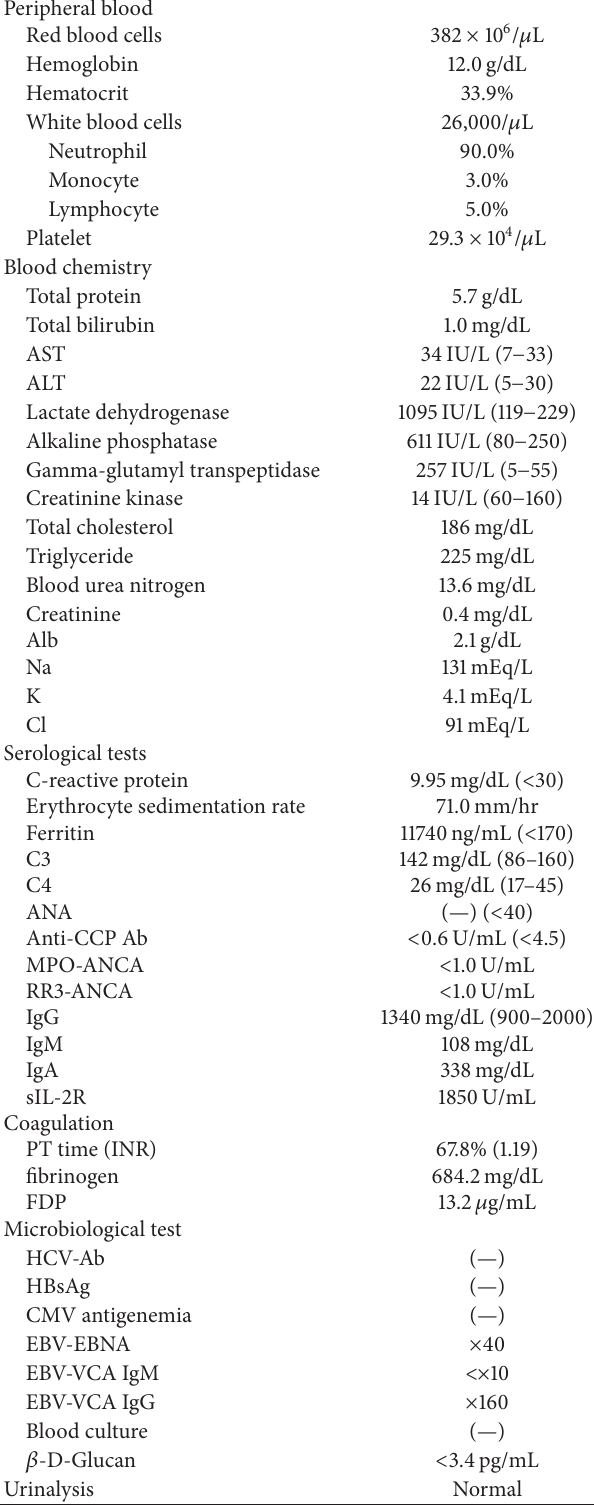
Table 1: Laboratory findings on